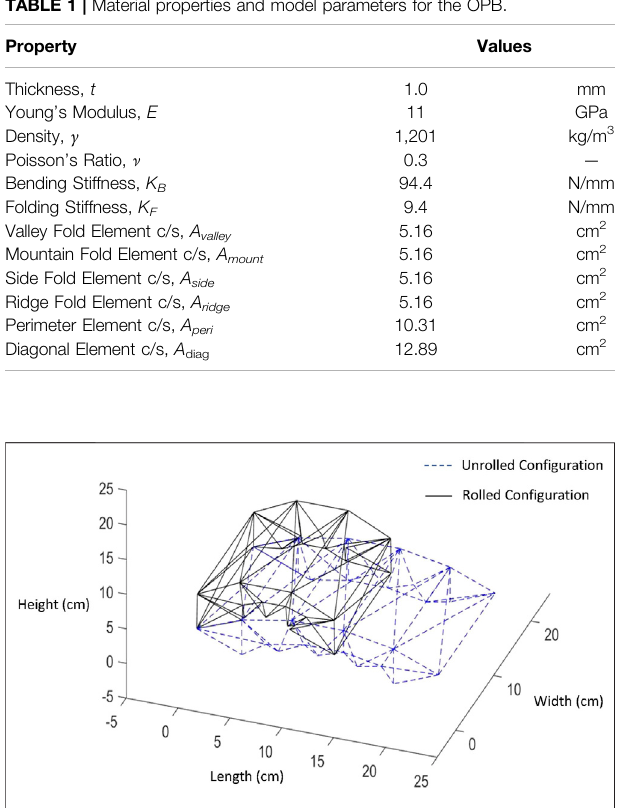
FIGURE 5 | Initial unrolled con fi guration (represented by discontinuous blueline)and fi nalrolledcon fi guration(representedbycontinuousblackline)of the OPB structure using DR